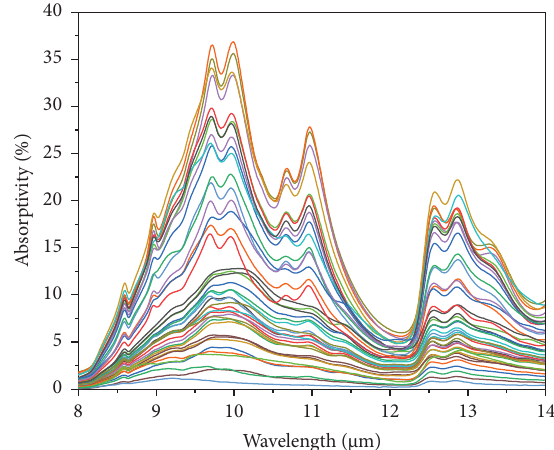
Figure 2: Polarized infrared absorption spectra of the